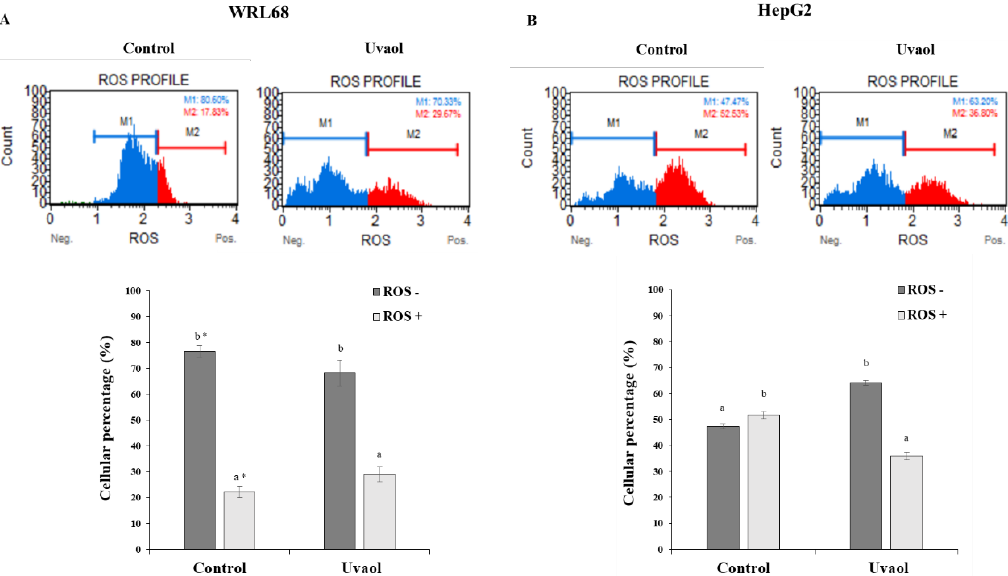
Figure 6. Reactive oxygen species (ROS) quantification was performed according to the Muse™ Oxidative stress kit. Panel ( A ) corresponds to the WRL68 cells and panel ( B ) to the HepG2 cells. Treatments included cells not treated and cells incubated with IC 50 of uvaol for 24 h. Top: dot plots show a representative experiment of the different treatments. Bottom: percentage of ROS negative (ROS−) and ROS positive (ROS+) values observed for each treatment. Values are expressed as mean ± SEM (n = 12). Different letters indicate significant differences between ROS levels for each treatment and an asterisk indicates significant differences between cell lines for each treatment and ROS levels ( p < 0.05).